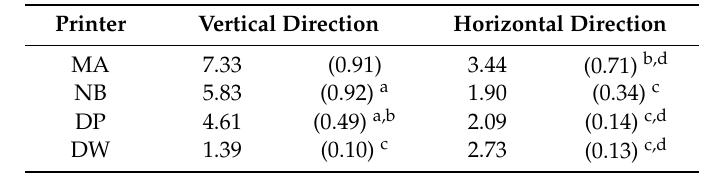
Table 3. Surface roughness ( µ mRa) on the sidewall of patterns measured in the vertical and horizontal directions to the tooth